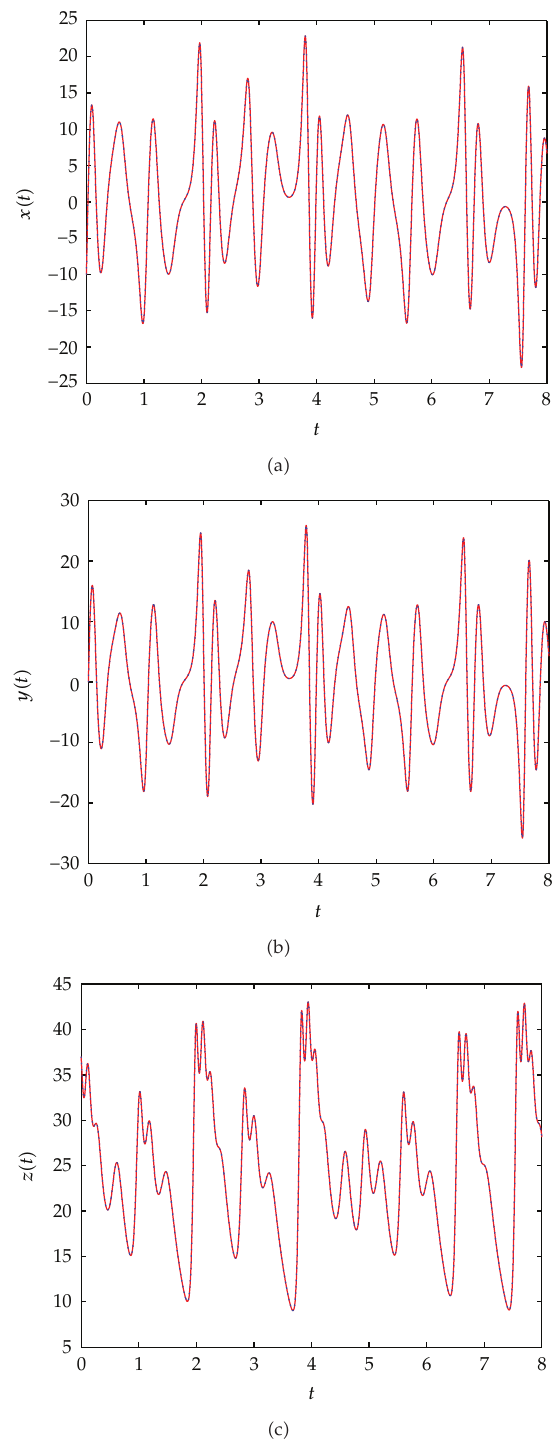
Figure 3: Time series PSLM (cid:2) solid line (cid:3) and ode 45 (cid:2) dots (cid:3) results for nonchaotic case with parameters a (cid:7) 35, b (cid:7) 3, and c (cid:7)